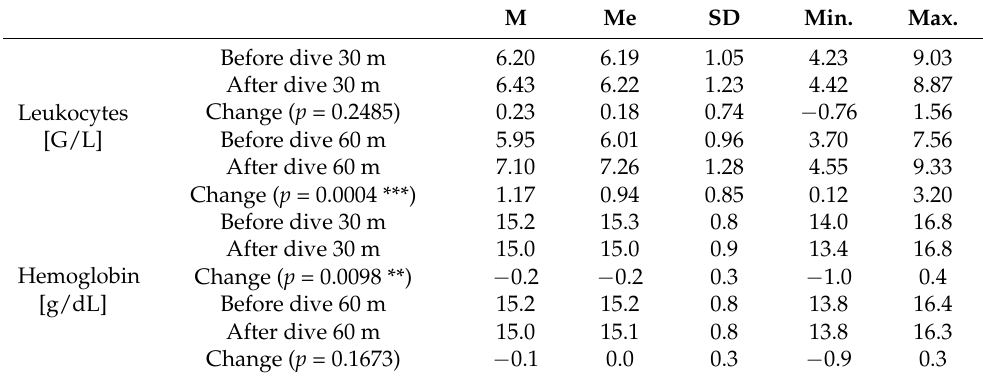
Table 7. Descriptive statistics characterizing the distribution of leukocytes and hemoglobin counts in individual tests, showing the significance of changes between tests completed before and after exposure.